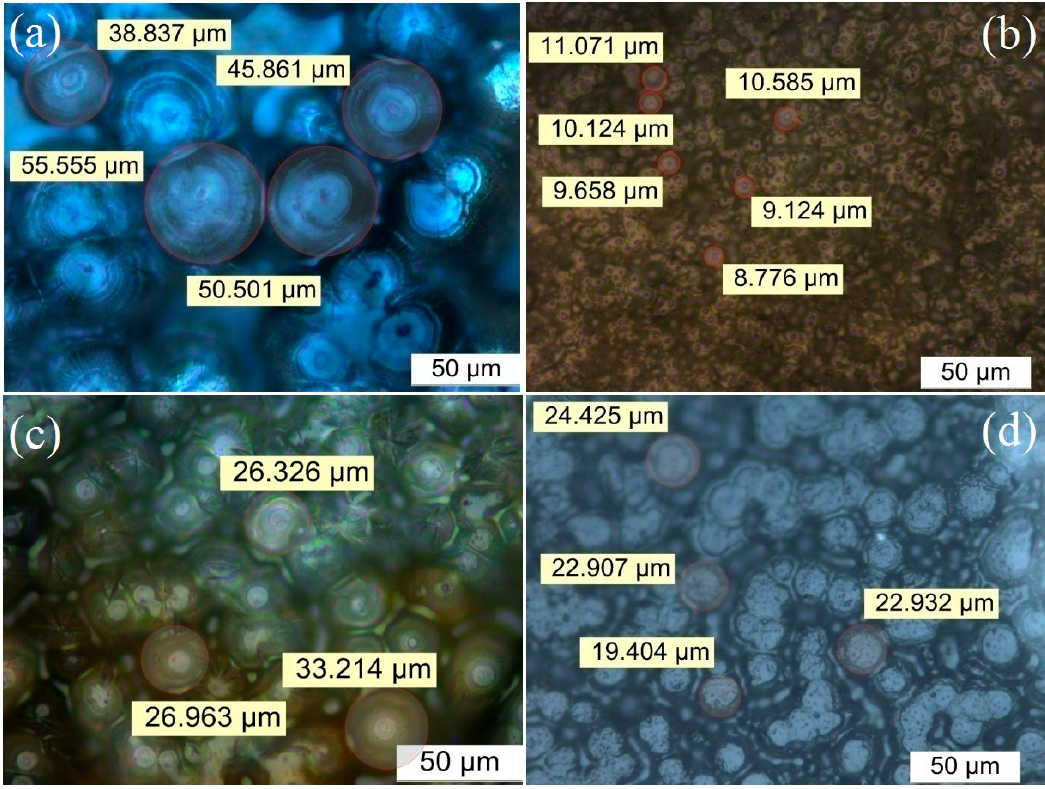
Figure 3. PLM images of neat LDPE and ZnO / LDPE composites: ( a ) LDPE, ( b ) N3, ( c ) M3, and ( d ) N2M1.